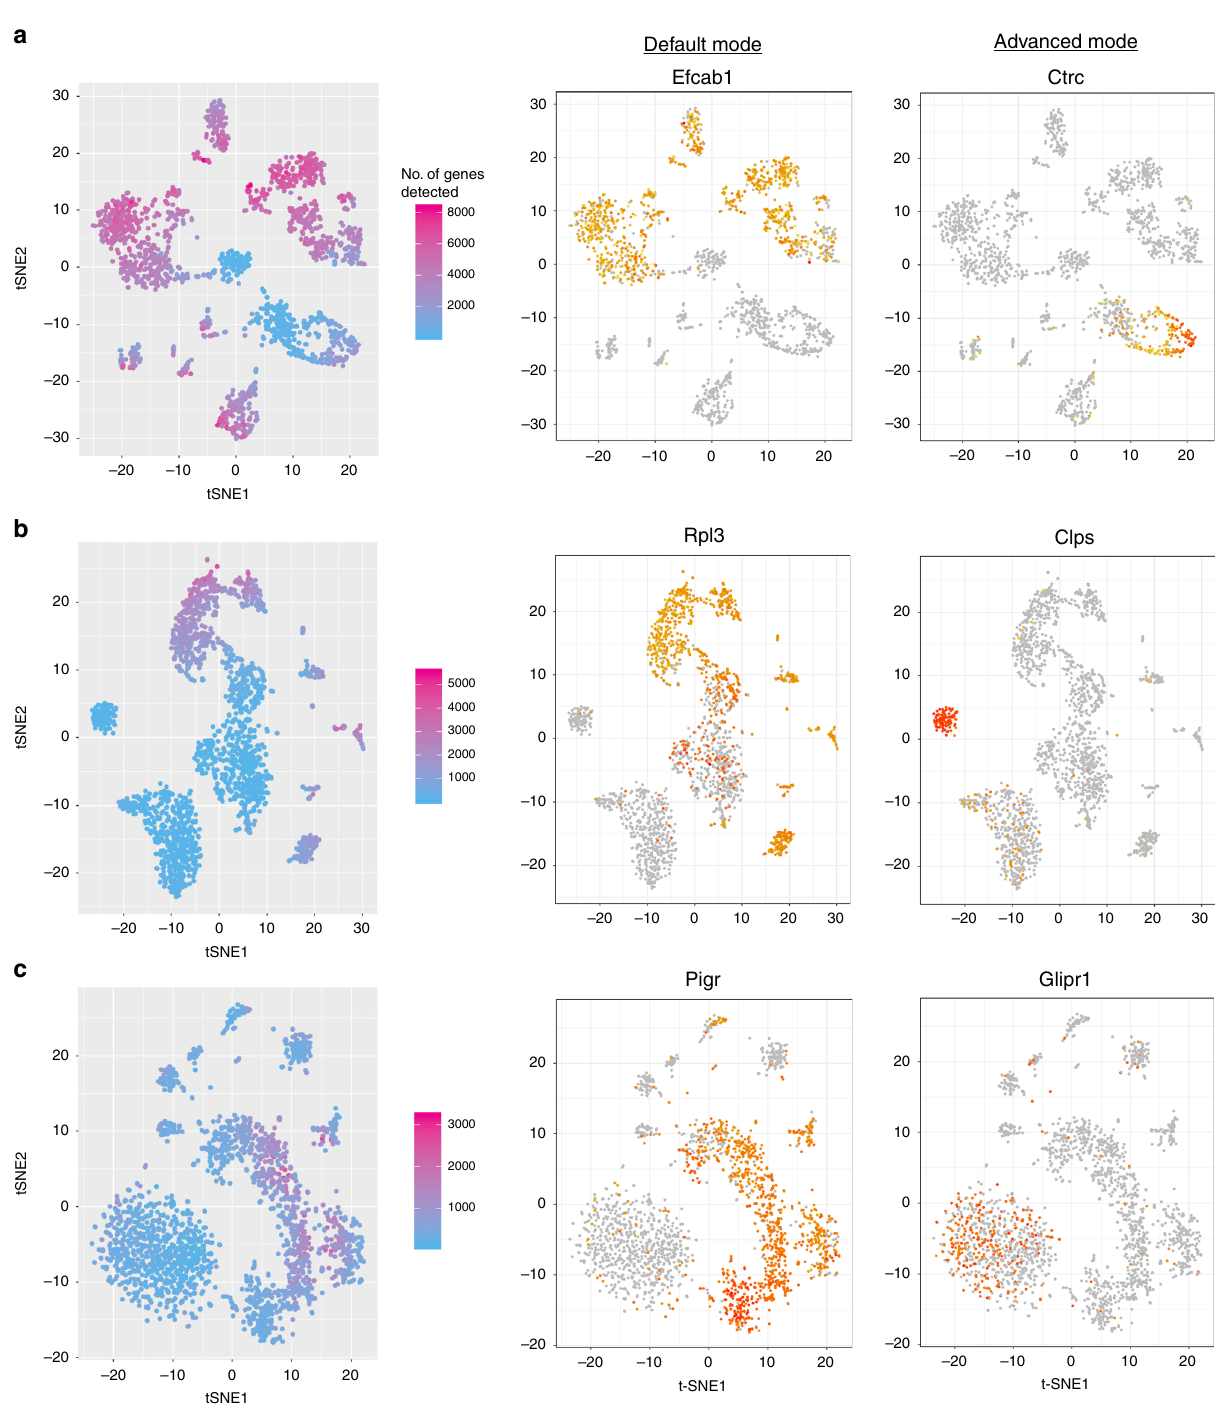
Fig. 6 Example results of default versus advanced mode of singleCellHaystack. A t-SNE plot (left), the expression of top-scoring DEGs in the default mode (center) and advanced mode (right) are shown for a the Tabula Muris pancreas (FACS-sorted data), b the Tabula Muris lung (P8 12; Micro fl uidic droplet), and c the Mouse Cell Atlas small intestine 2 dataset. The color scale for gene expression (center and right panels) is as in Fig.